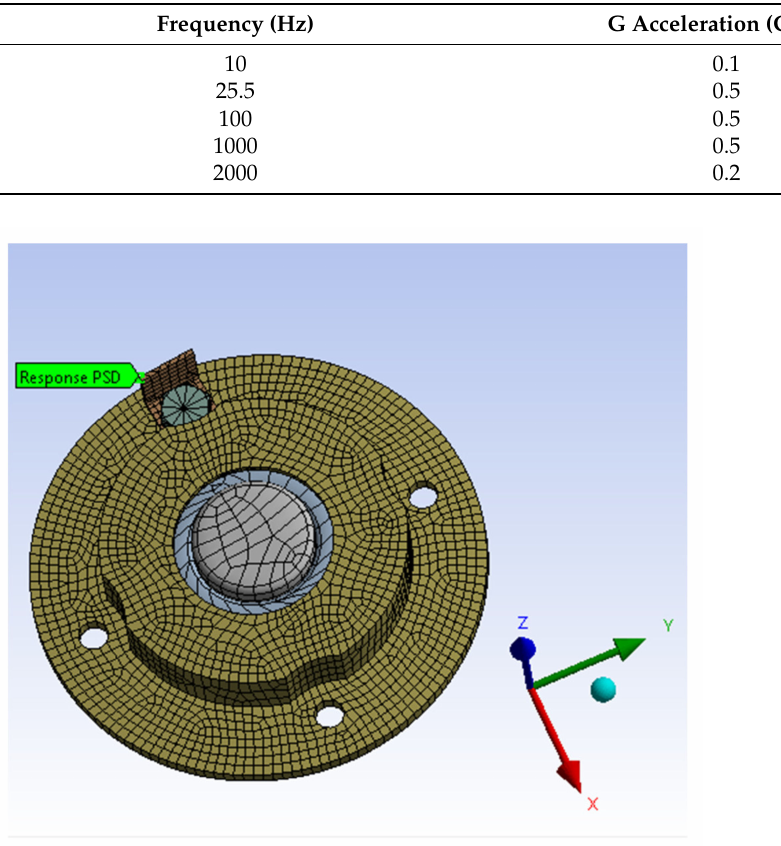
Table 8. Random Input PSD (10–2000 Hz.).